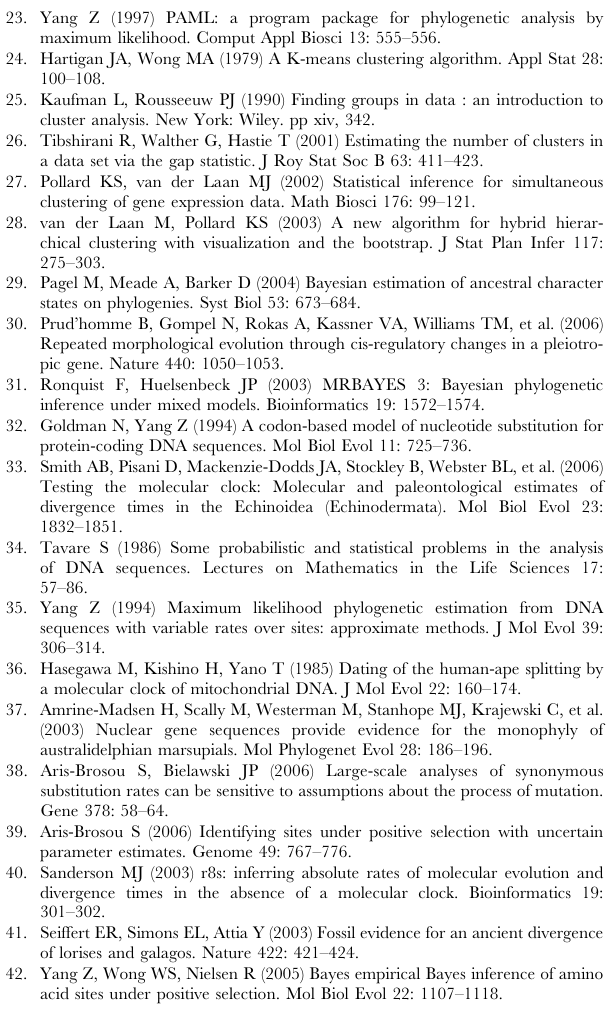
Figure S1 Maximum likelihood estimates of divergence times for the codon data partitioned according to the estimated local clock models. Times were estimated using (A) k-medoids with the gap statistic, (B) Median Silhouette Splits (MSS) and (C) Hierarchical Ordered Partitioning and Collapsing Hybrid (HOPACH) and are given in million years ago (MYA). Filled circles indicate the seven calibration points on the trees scaled to time (A–C); the other trees (D–F) are scaled to the expected number of substitutions per codon.